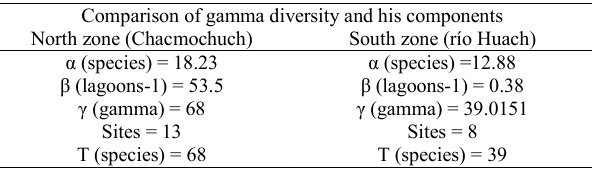
Table 3. Gamma diversity values obtained for Chacmochuch Lagoon System (north zone) and comparison of the values with Avilés-Torres et al. (2001) in río Huach Lagoon System (south zone) of the Mexican Caribbean. Comparison of gamma diversity and his components North zone (Chacmochuch) South zone (río Huach) α (species) =